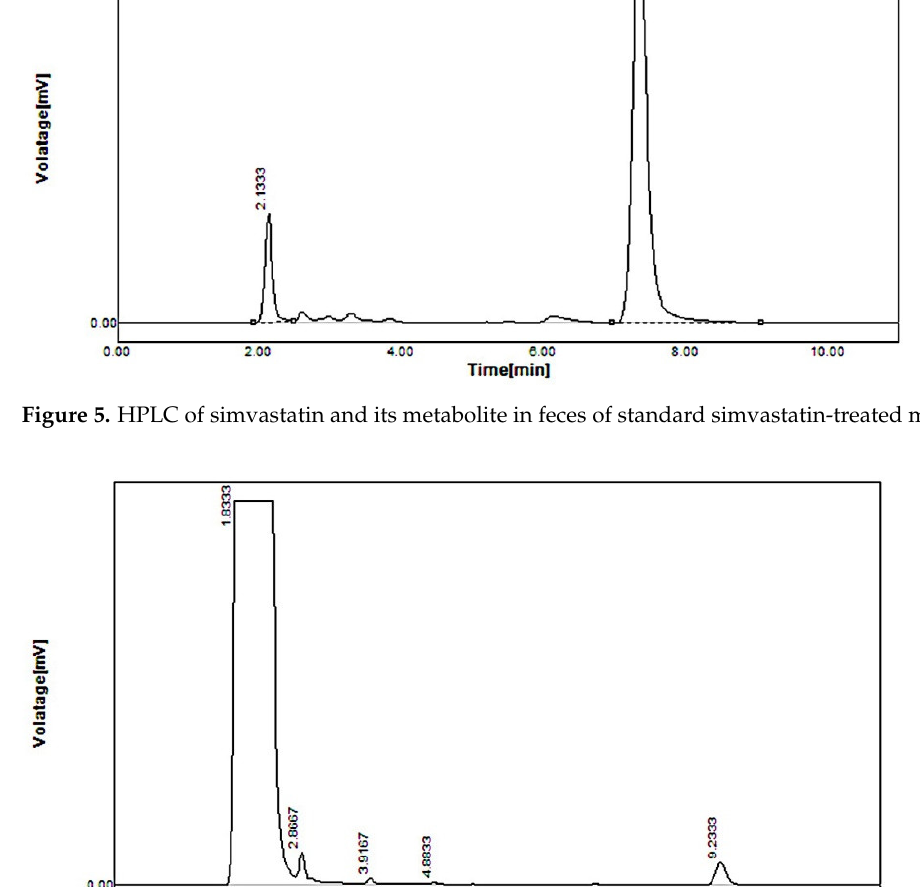
Figure 6. HPLC of simvastatin and its metabolite in feces of CS − SS nanoformulation − treated mice.